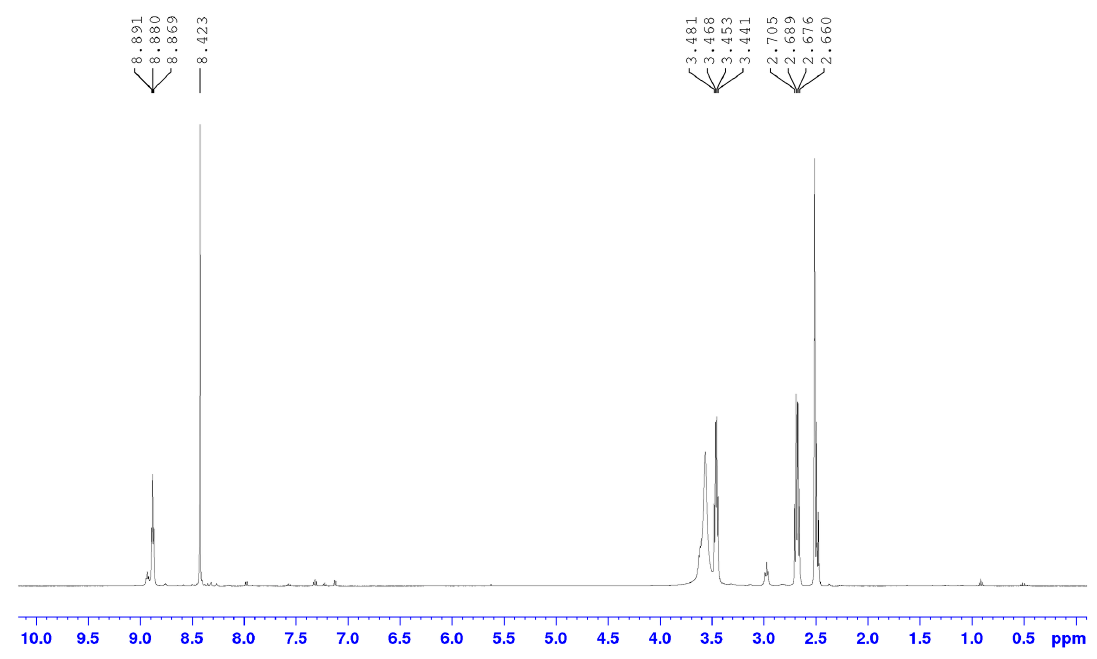
Figure 2. 1 H NMR spectra of N 1 ,N 3 ,N 5 -tris(2-Mercaptoethyl)benzene-1,3,5-tricarboxamide ( 3 ) in DMSO-d 6 .